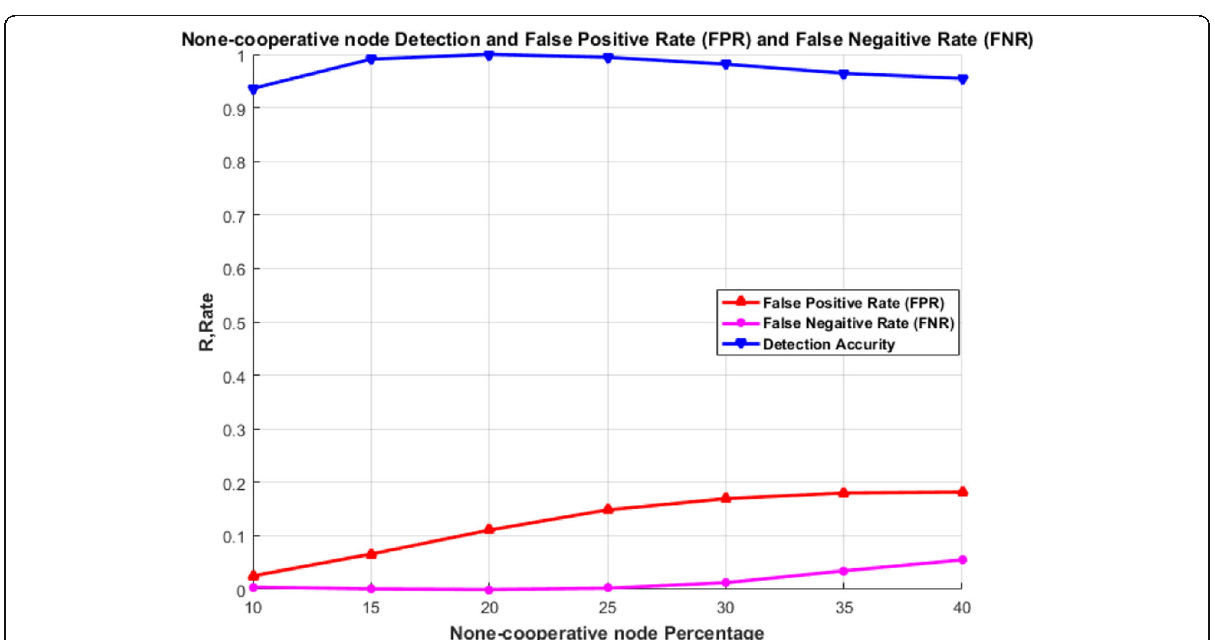
Fig. 11 DA, FPR, and FNR metrics in the proposed